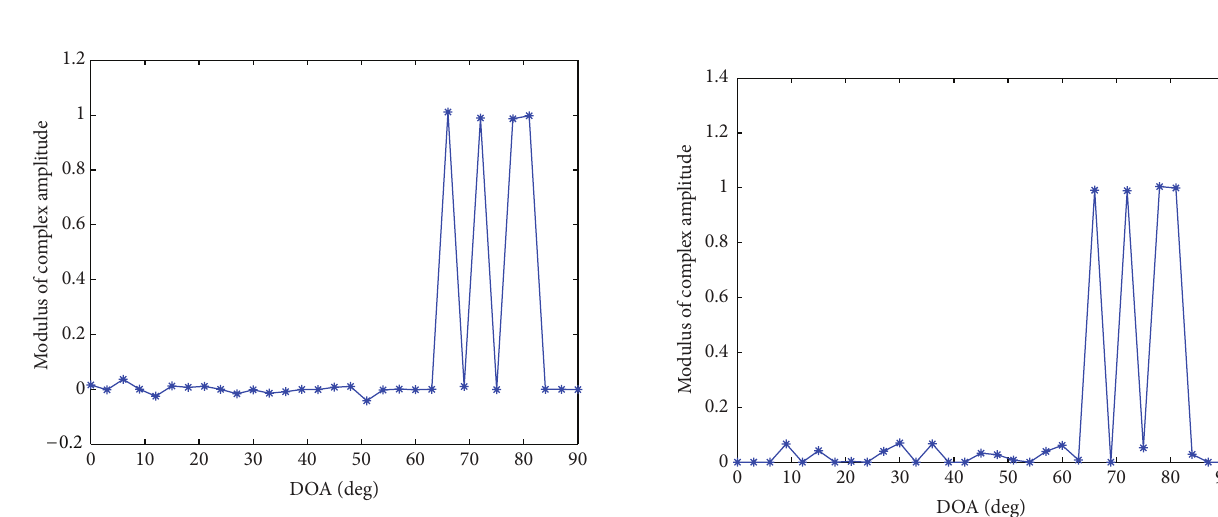
Figure 12: DOA estimation using